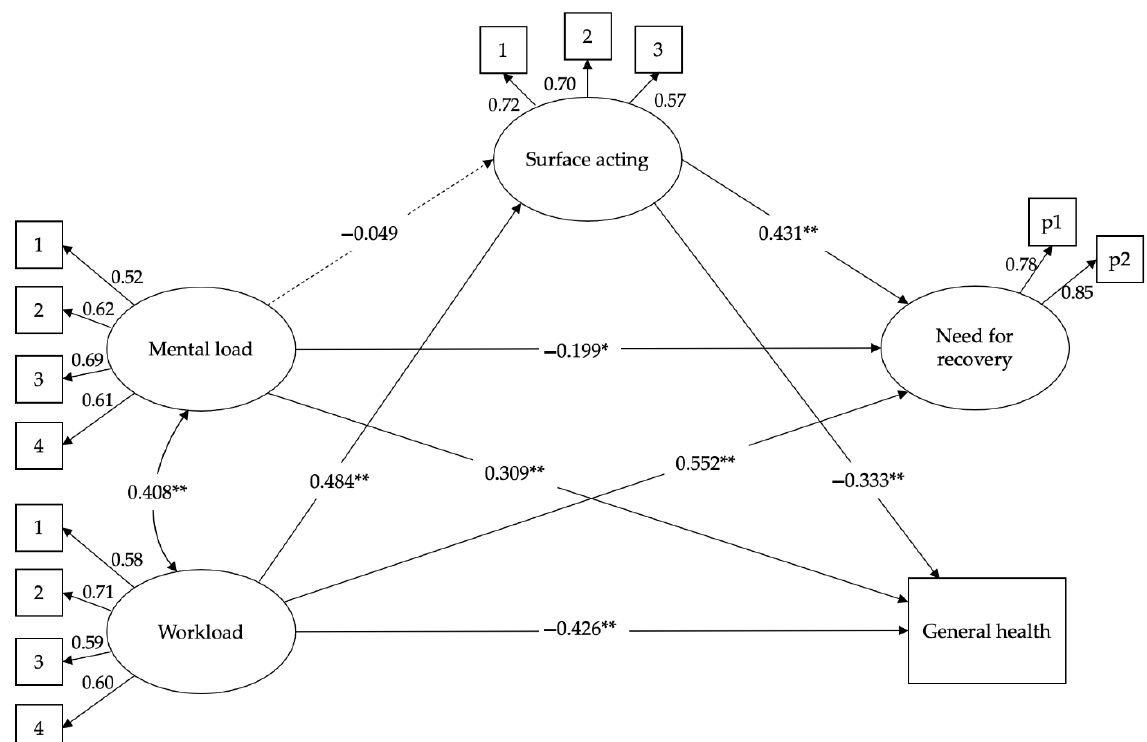
Figure 2. The structural model for the front-office sample ( N = 734). * p < 0.05 **, p < 0.01. As represented in Figures 1 and 2, the two models show some differences, validating hypothesis 3. In the back-office workers’ model, workload is positively related to surface acting ( β = 0.476 **, se = 0.07) and need for recovery ( β = 0.535 **, se = 0.07), and